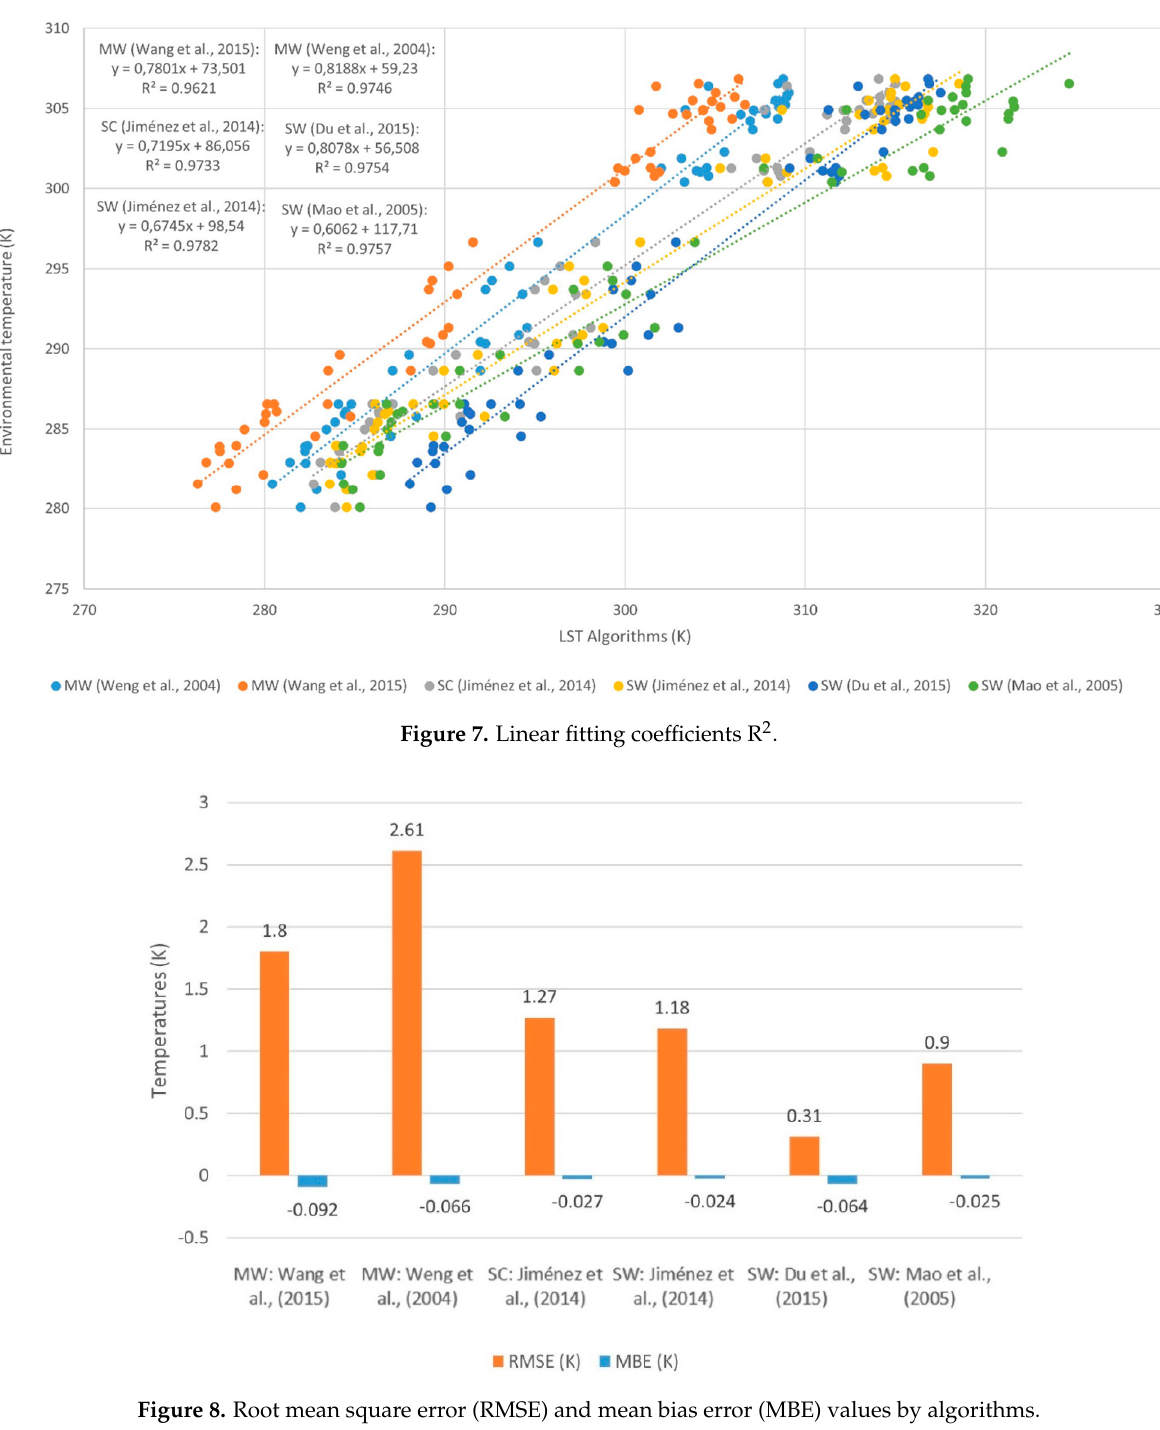
Figure 8. Root mean square error (RMSE) and mean bias error (MBE) values by algorithms.